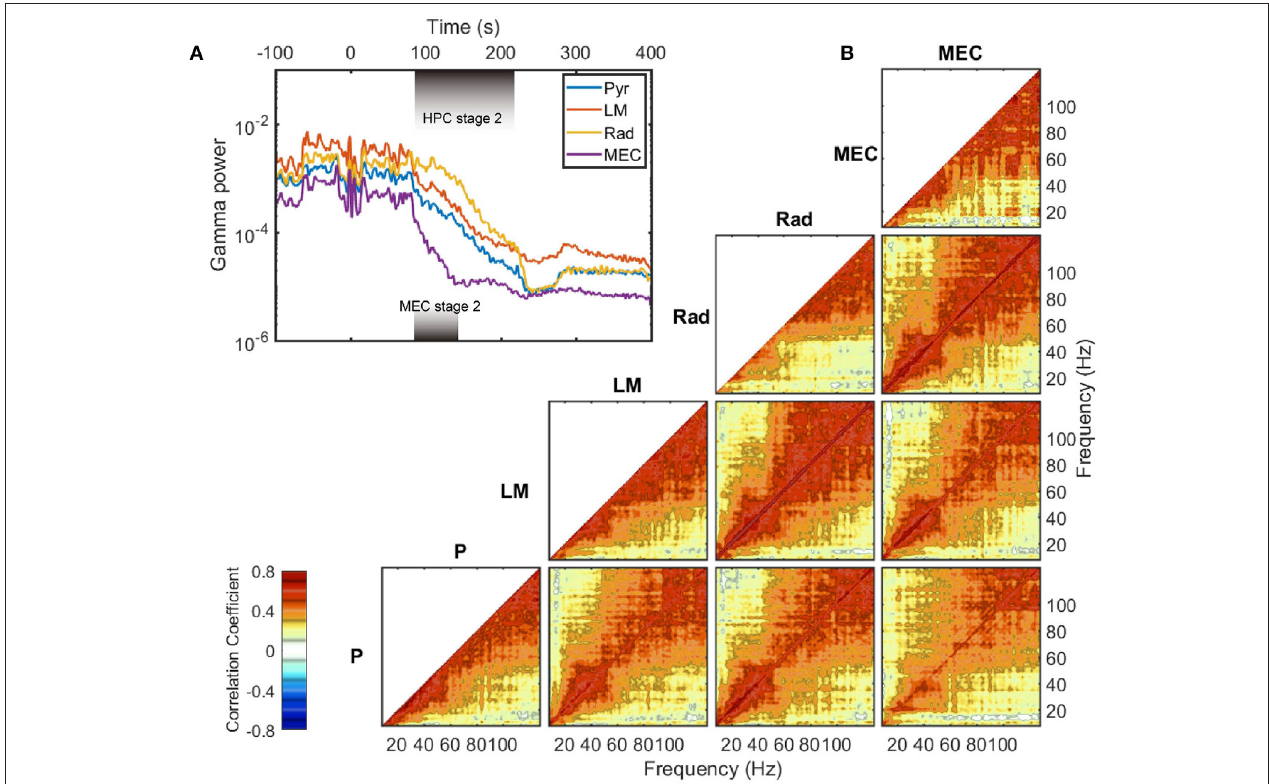
FIGURE 5 | Gamma decay during stage 2. (A) The evolution of LFP variance band-passed in gamma range (60–120 Hz) in different layers. The durations of stage 2 are different in HPC and MEC regions, and are marked with shaded rectangles in the plot. Data from rat 782. (B) Averaged auto- and cross correlation coefficient of decay rate during stage 2. The decay rate (defined as in Figure 4B ) of each frequency component was computed and treated as a time series. Then the correlation coefficients were estimated for time series pairs from either the same layer or different layers. Within a region, the correlation of a frequency’s decay rate with itself is equal to one. Furthermore, as the autocorrelations are symmetric, only one half is presented. The cross-correlation of decay rate, however, can vary across unity and is not necessarily symmetric. For instance, the bottom right panel represents the correlation of the decay rates in pyramidal (y axis) to that in MEC layer (x axis). Note that for the MEC-related panels (the rightmost column), the data were averaged between rat 730 and rat 782, and the decay rates were estimated over the MEC stage 2 period. For other panels, the results were averaged across all the five rats. P, pyramidal layer; Rad, radiatum; LM, lacunosum-moleculare; MEC, medial entorhinal